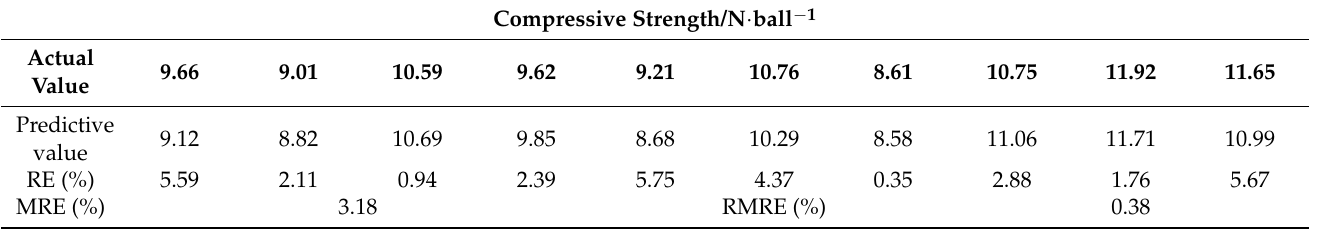
Figure 7. Variation trend of errors of burst temperature prediction model. Table 10. Comparison of compressive strength prediction results.